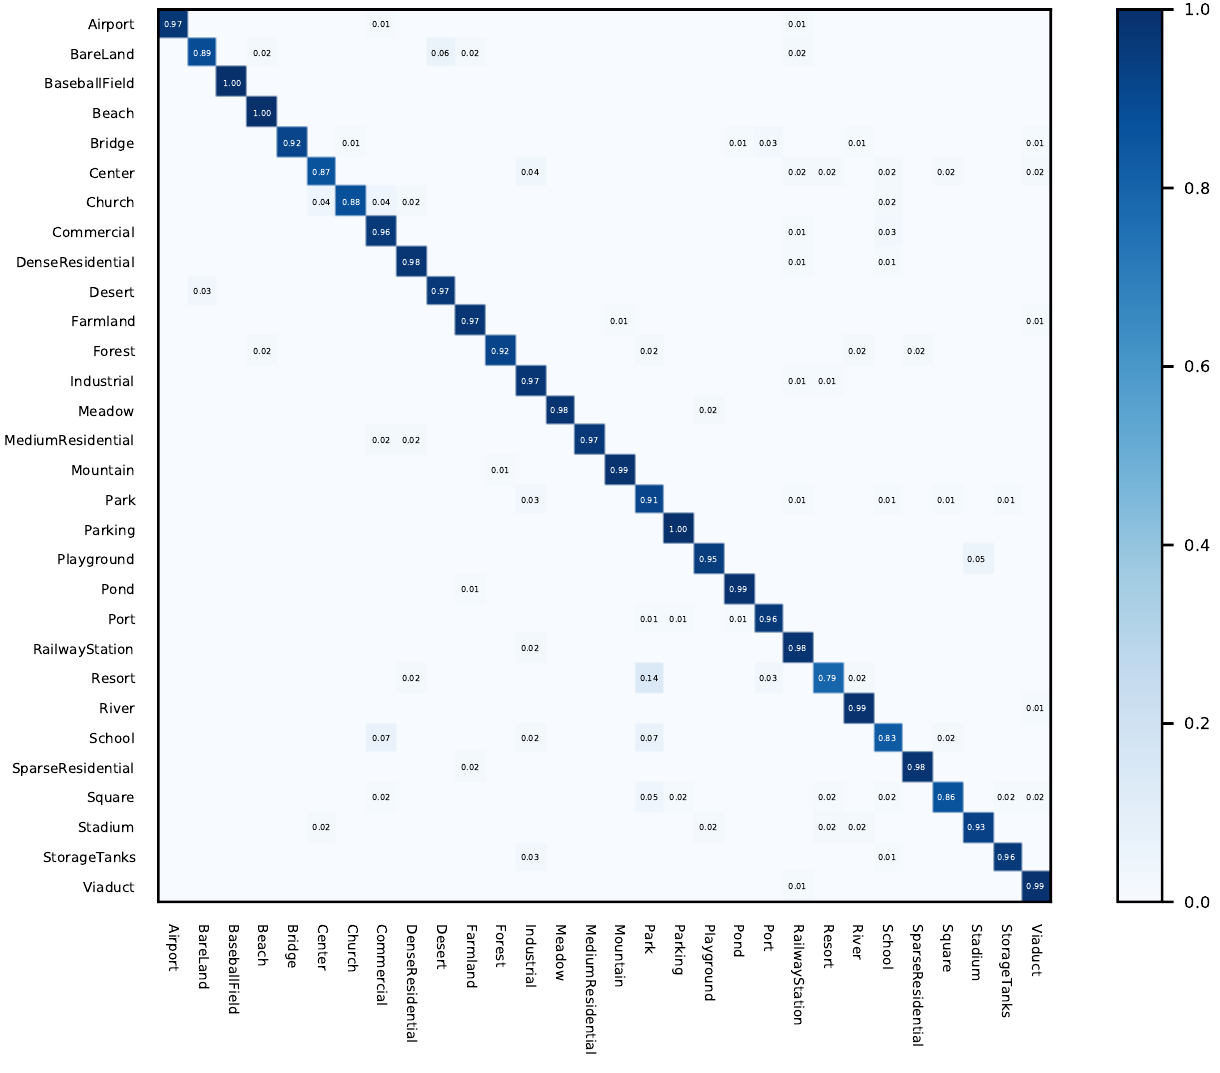
Figure 6. Confusion matrices produced by the proposed approach. We set the training ratio as 80% on the AID dataset.